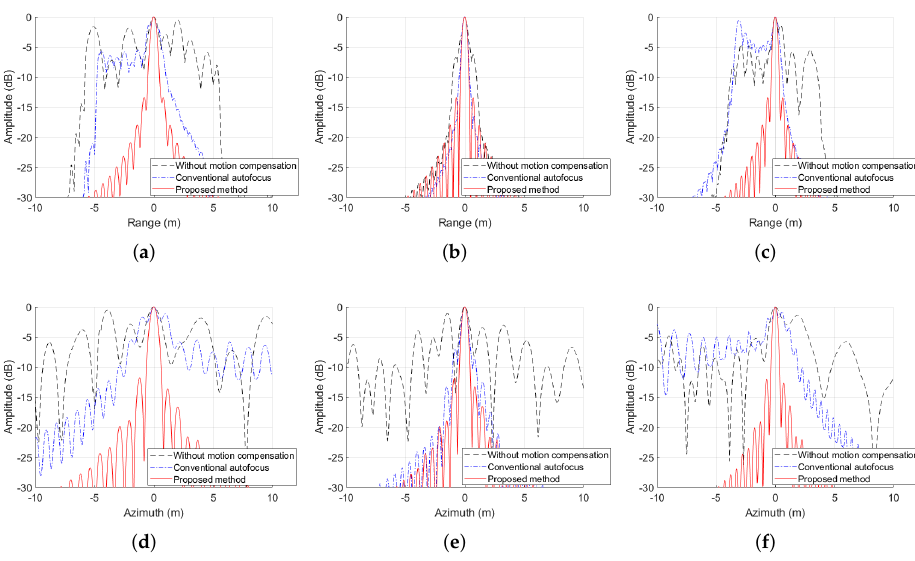
Figure 13. Profile properties of simulation results: ( a ) range profiles of A; ( b ) range profiles of B; ( c ) range profiles of C; ( d ) azimuth profiles of A; ( e ) azimuth profiles of B; ( f ) Azimuth profiles of C.